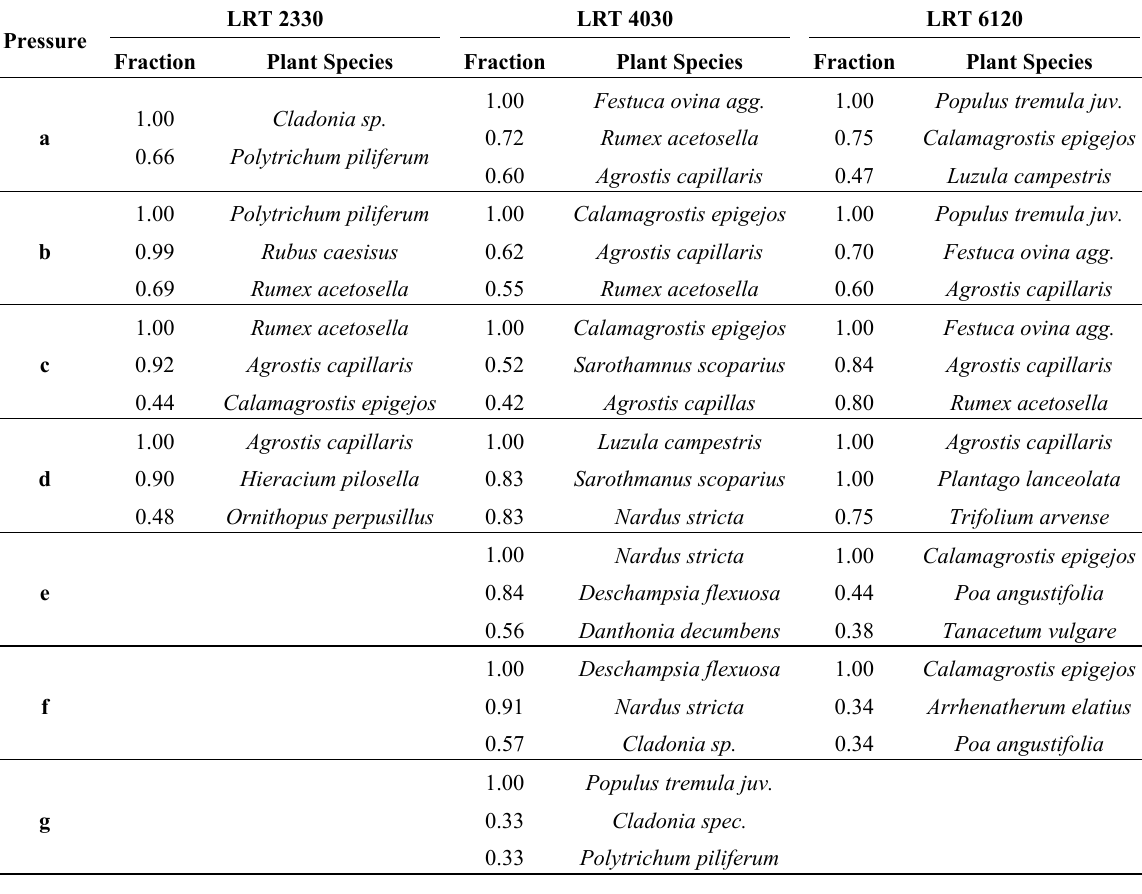
Table 3. Pressure-complex definition on the basis of plot localization within a region of maximum pressure strengths on the ordination plane. Species cover is aggregated over a certain number of plots by min/max-normalized fractional cover values in order to assess the direction of species influence on habitat pressures.